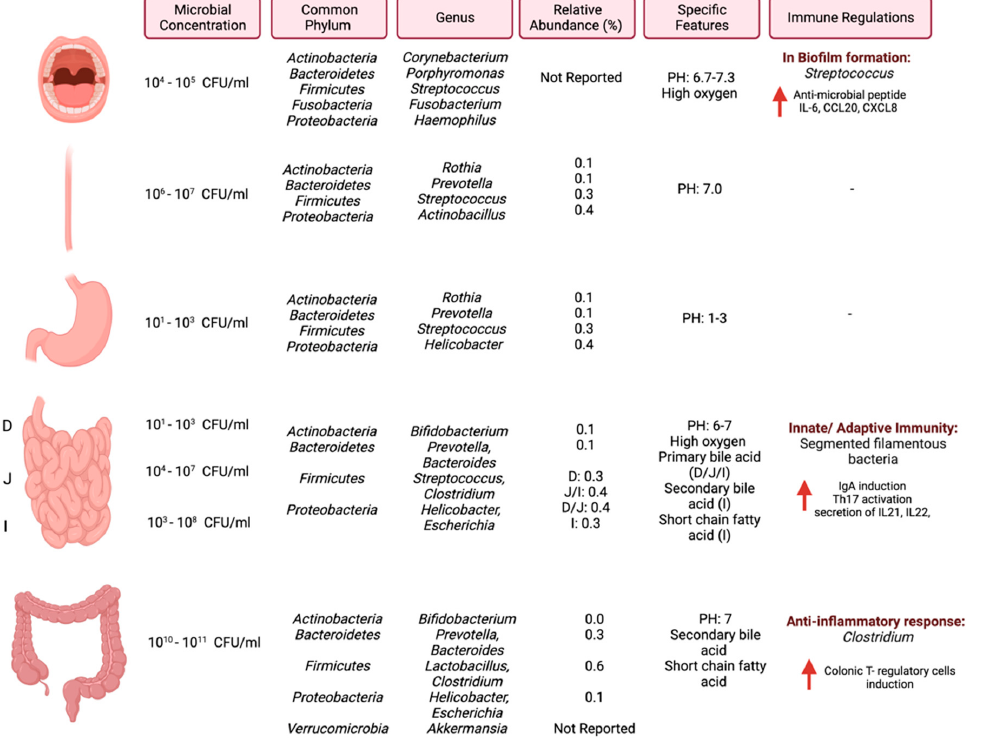
Figure 1. Schematic illustration of regional diversity of the microbiome along the GI tract. The figure is divided into different regions of the GI tract and highlights the microbial concentration ranges, common phylum and genus, relative abundance [27], and immune regulations specific to each region. “Created with